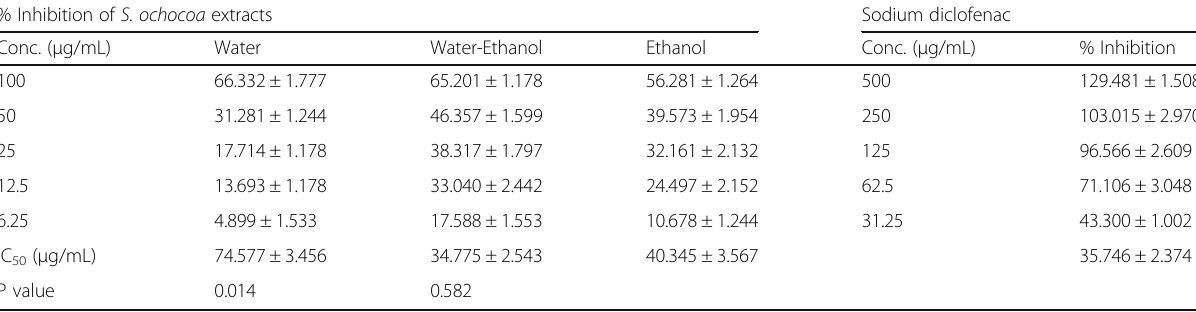
Table 4 Effect of S. ochocoa extracts and diclofenac sodium against protein denaturation % Inhibition of S. ochocoa